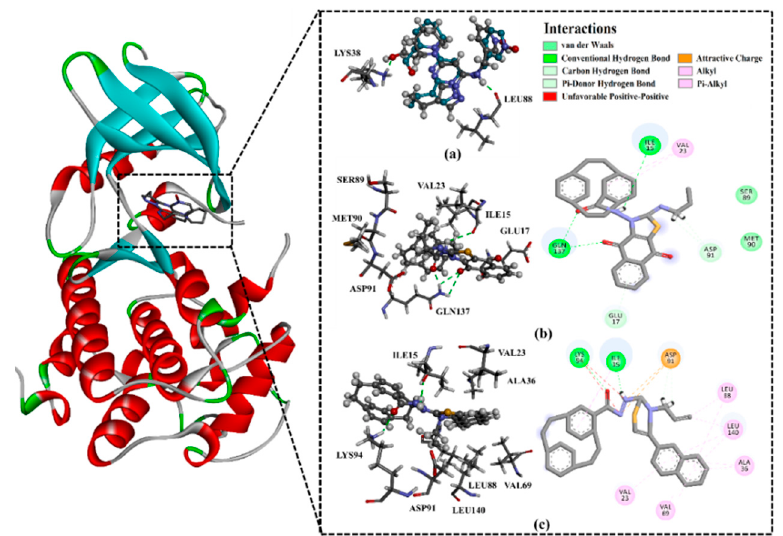
Figure 12. ( a ) 3D representation of the predicted binding mode (in grey) and experimental structure (in cyan) of Dinaciclib, ( b ) 2D and 3D representations of the binding pose and ligand interactions of 3c , and ( c ) 2D and 3D representations of the binding pose and ligand interactions of 8c with the CDK1 receptor (PDB: